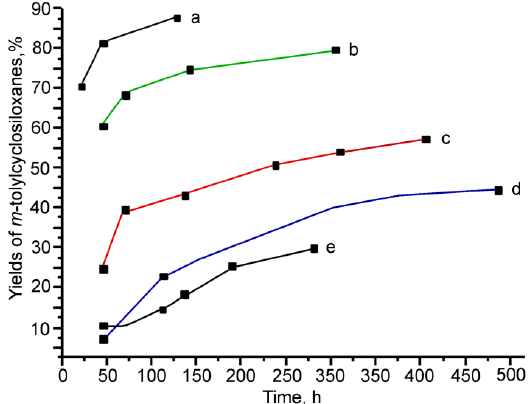
Figure 1. Dependence of the yields of m -tolylcyclosiloxanes from the hydrolysis-condensation reaction of 1 on time at di ff erent concentrations C HCl in water-acetone solutions: curve a , C HCl = 0.40; b —0.15; c —0.076; d —0.054; and e —0.038 mol L − 1